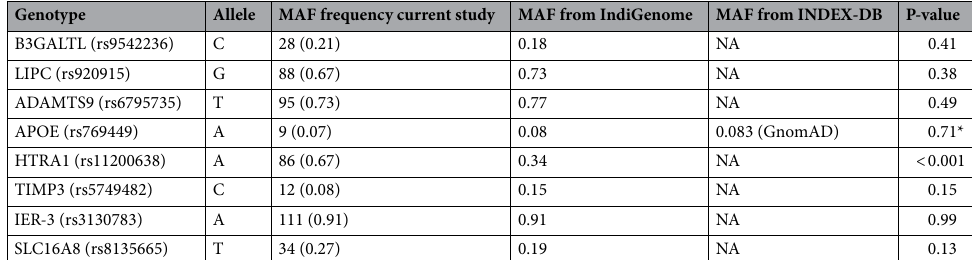
Table 3. Comparison of minor allele frequency derived from IndiGenome and INDEX-DB GWAS with current study. MAF: Minor allele frequency; *p-value based on comparison between IndiGenome and current study.